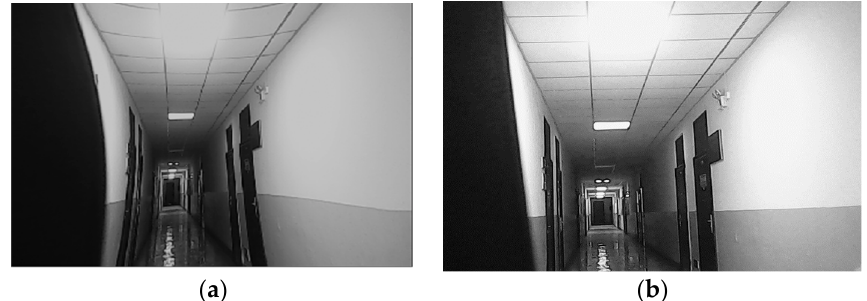
Figure 2. Aberration correction contrast. ( a ) Before distortion correction; ( b ) after distortion correc- tion.